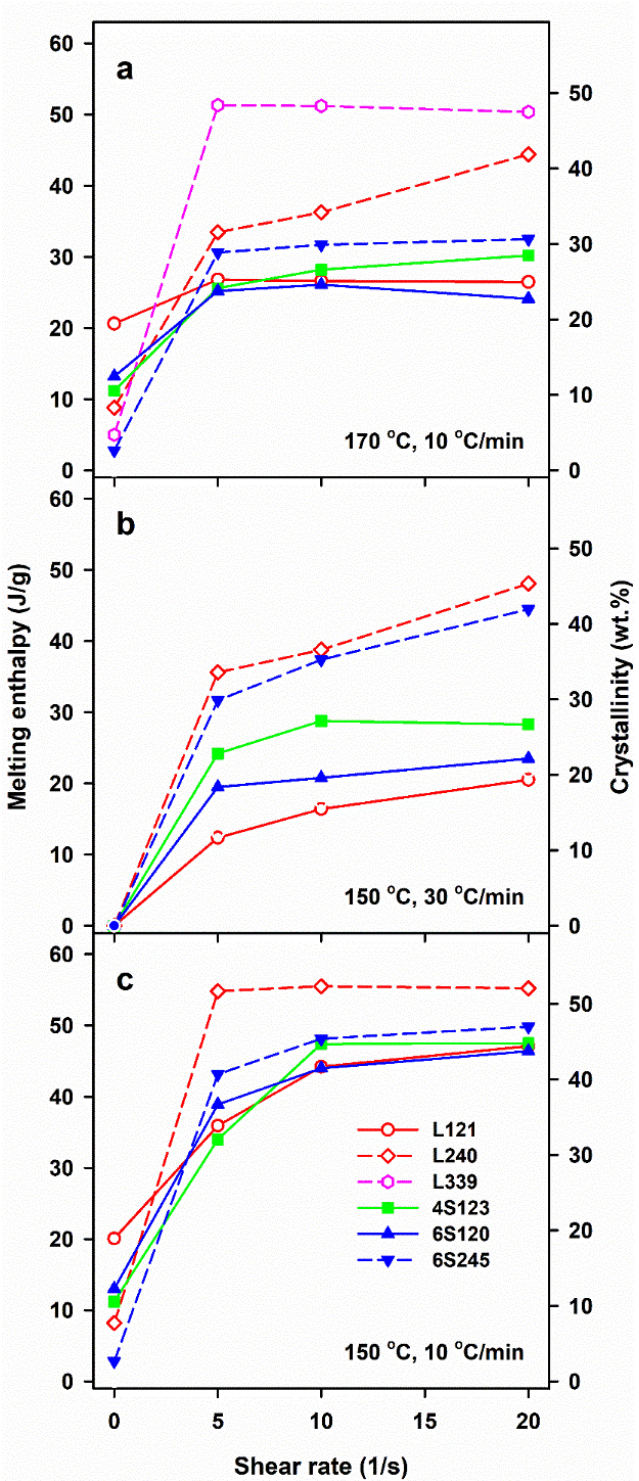
Figure 2. Melting enthalpy, H mc , of crystalline phase formed in PLLAs during cooling at 10 and 30 °C/min after shearing at 170 C ( a ) and 150 °C ( b , c ) versus shear rate, 𝛾̇ .